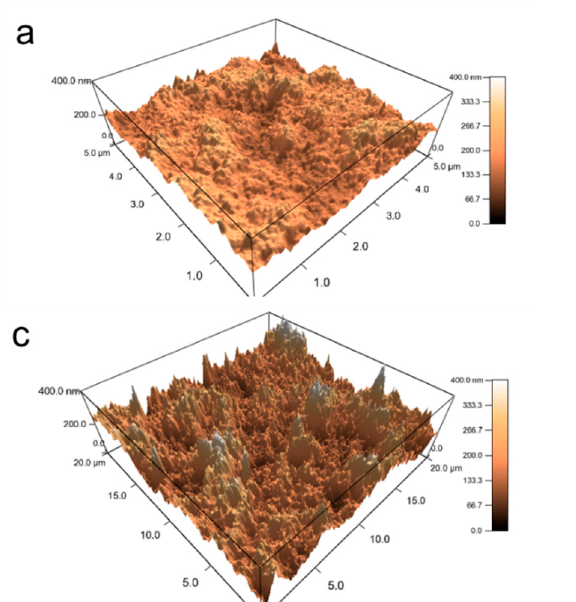
Figure 4. Representative AFM 3D height images of ( a ) PDDA-PSS-PDDA-Laponite 40 layers, surface roughness ~70 nm; ( b ) PDDA-PAA-PDDA-Laponite 40 layers, surface roughness ~145 nm; ( c ) PDDA-PSS-PDDA-Laponite 160 layers, surface roughness ~115 nm; and ( d ) PDDA-PAA-PDDA-Laponite 160 layers with fold-like surface topography, surface roughness ~560 nm. The scan size for ( a , b ) is 5 µm × 5 µm, and the scan size for ( c , d ) is 20 µm × 20 µm. All images are plotted for the same z -axis range of 400 nm.